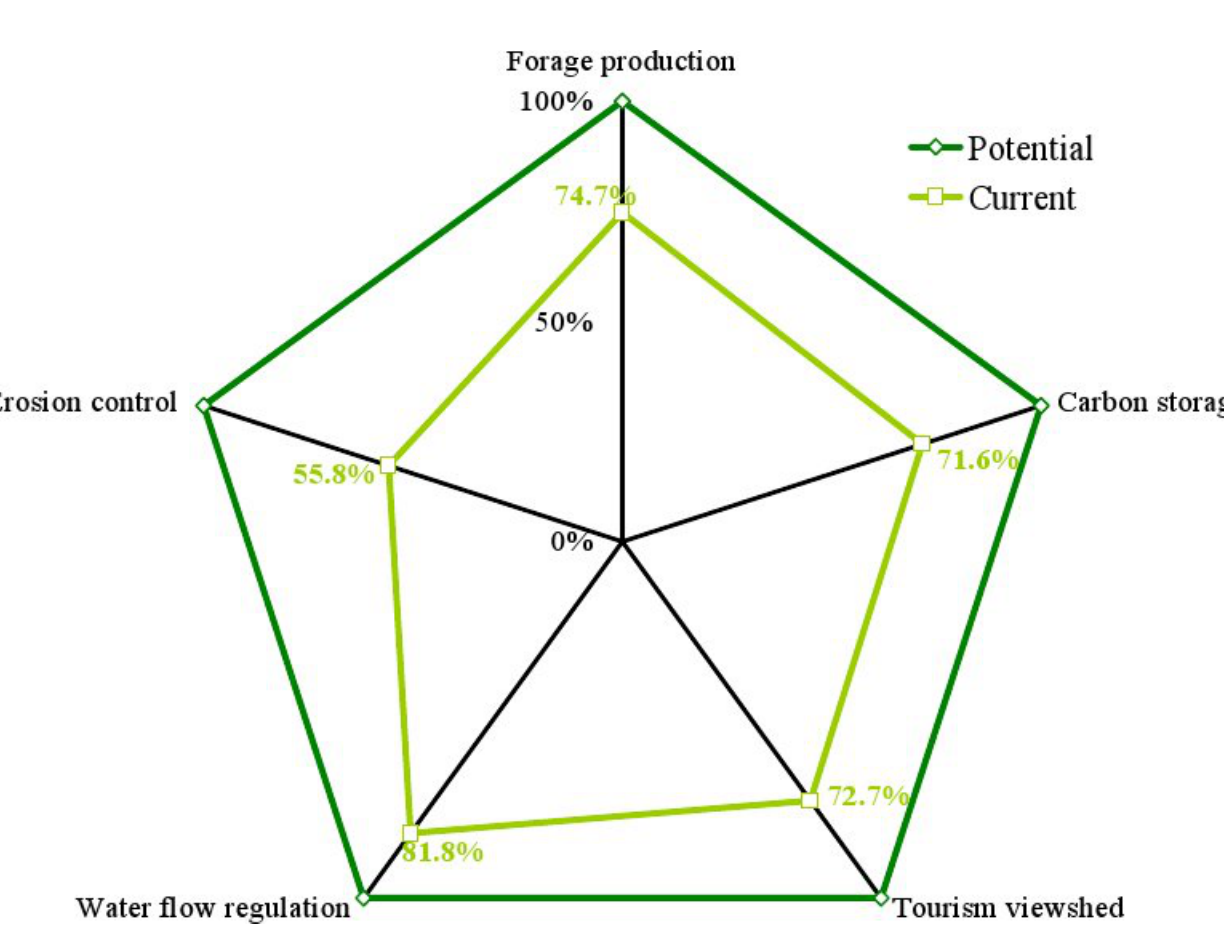
Figure 3. Changes in ecosystem service supply shown as a percentage of the potential service produced in the Little